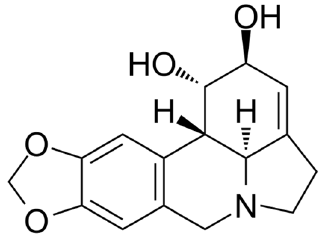
Figure 1. The structural formula of